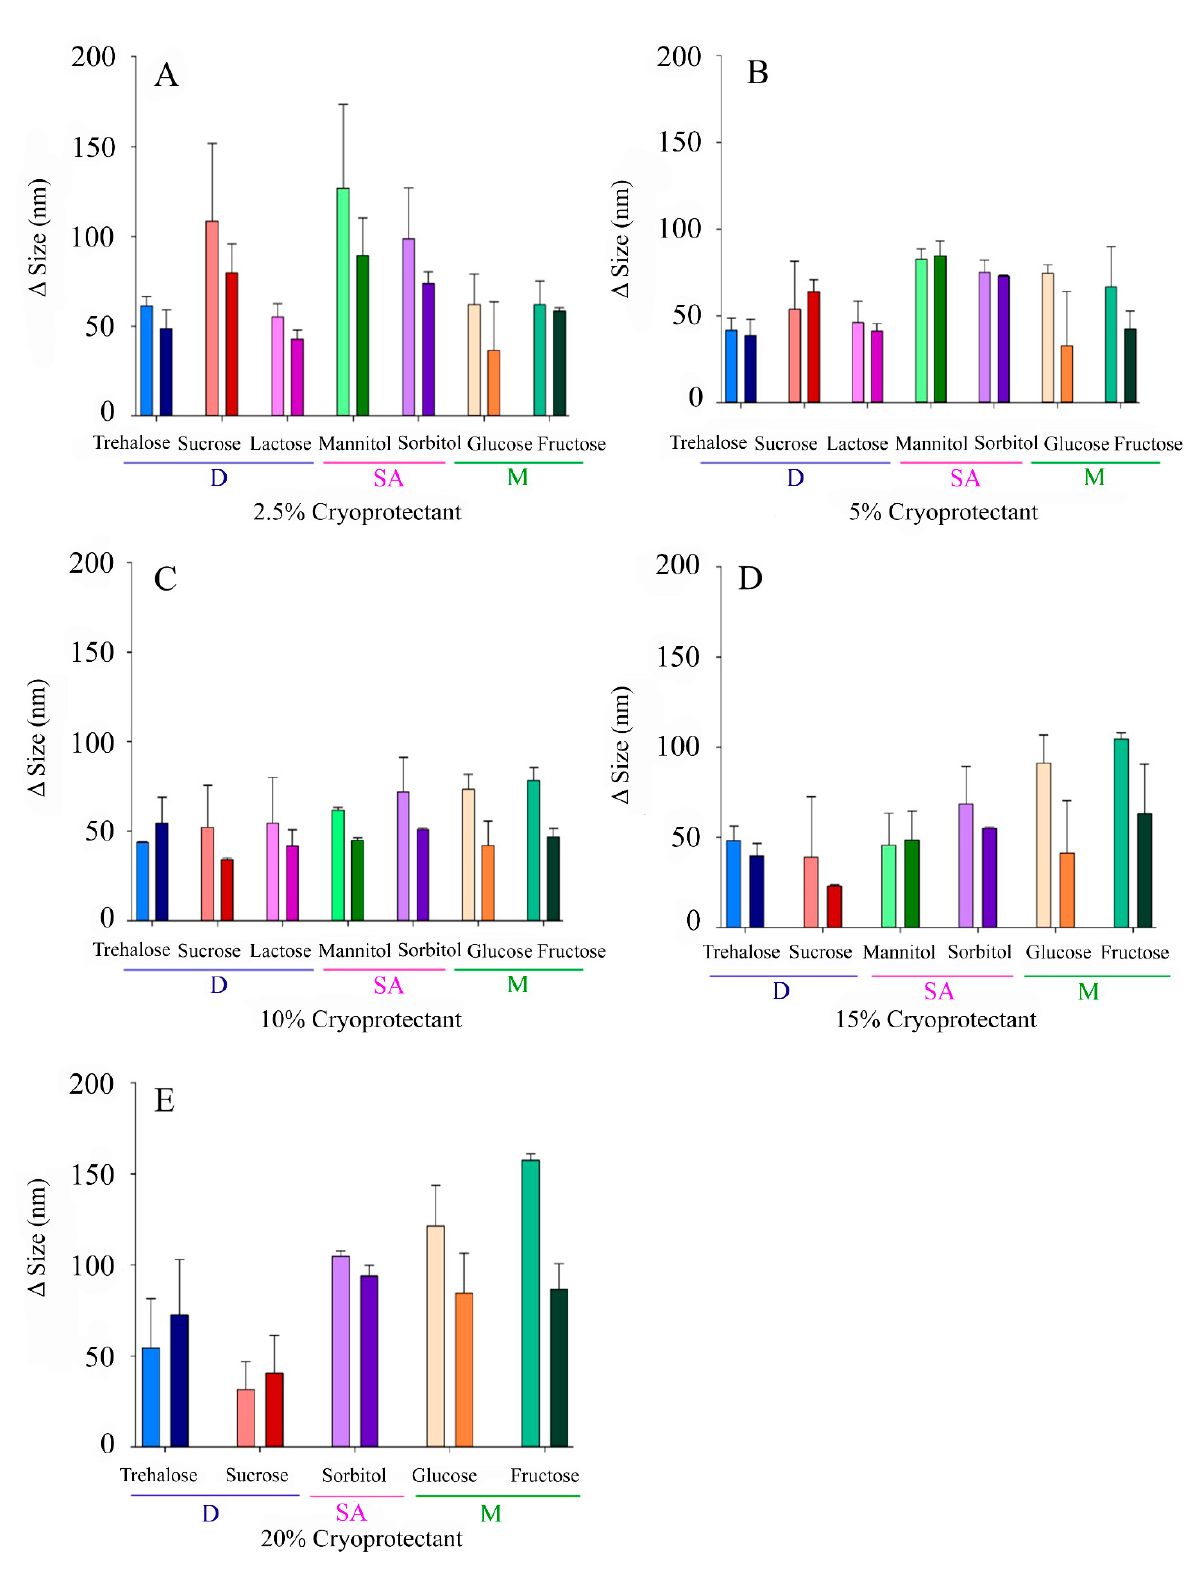
Figure 2. Increase in the sizes of the NLCs ( Δ Size) after lyophilization with different CPs at variable concentrations: ( A ) 2.5% w/v , ( B ) 5% w/v , ( C ) 10% w/v , ( D ), 15% ( w/v ), ( E ) 20% w/v . Light colours correspond to slow freezing processes and dark colours to fast freezing processes. The CPs are grouped according to their type into disaccharides (D), sugar alcohols (SA), and monosaccharides (M).